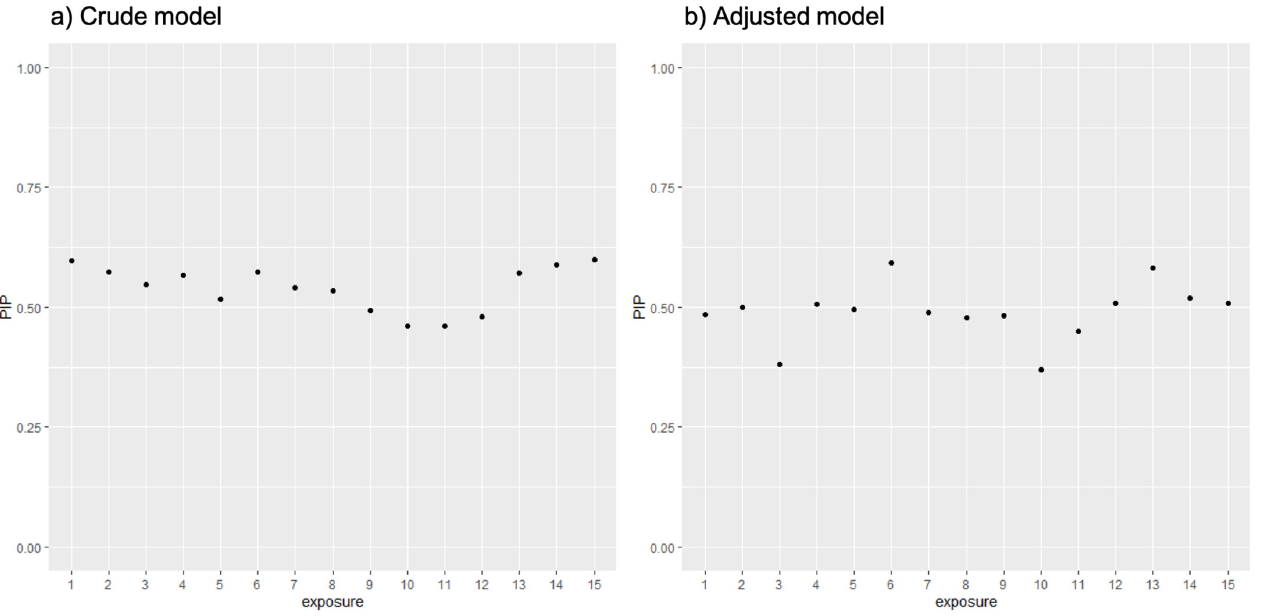
Figure A2. The plot of posterior inclusion probability of 15 REEs in BKMR model. ( a , b ) showed the posterior inclusion probability (PIP) in the crude model and the adjusted model, respectively. The PIPs of 15 REEs were all approximately 50% in both ( a , b ). It might indicate that these REEs were of similar importance in BKMR models and should be analyzed together.